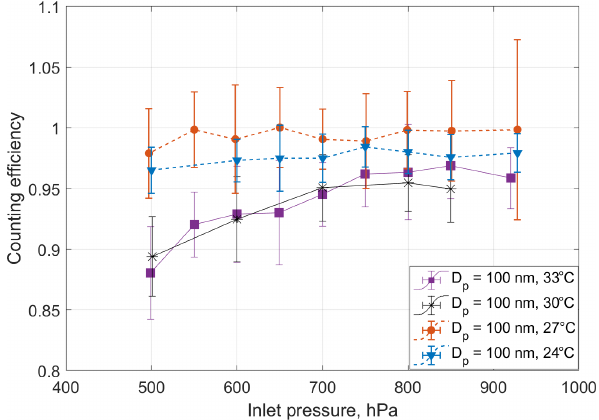
Figure 6. The vWCPC 3789 counting efficiency as a function of the inlet operation pressure at four conditioner temperatures of T cond = 24, 27, 30, and 33 ◦ C ( T ini = 59 ◦ C, T mod = 10 ◦